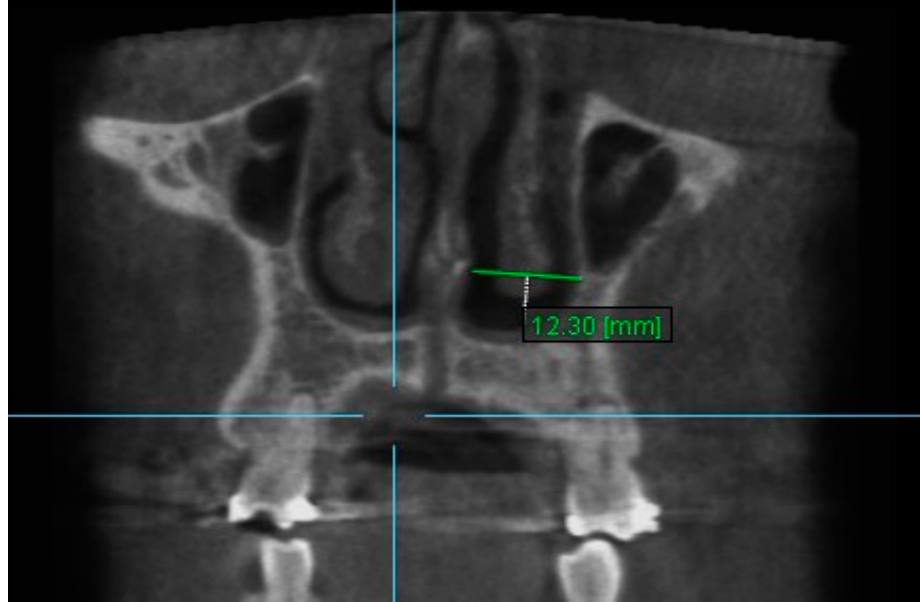
Figure 7. Nasal Width 5.